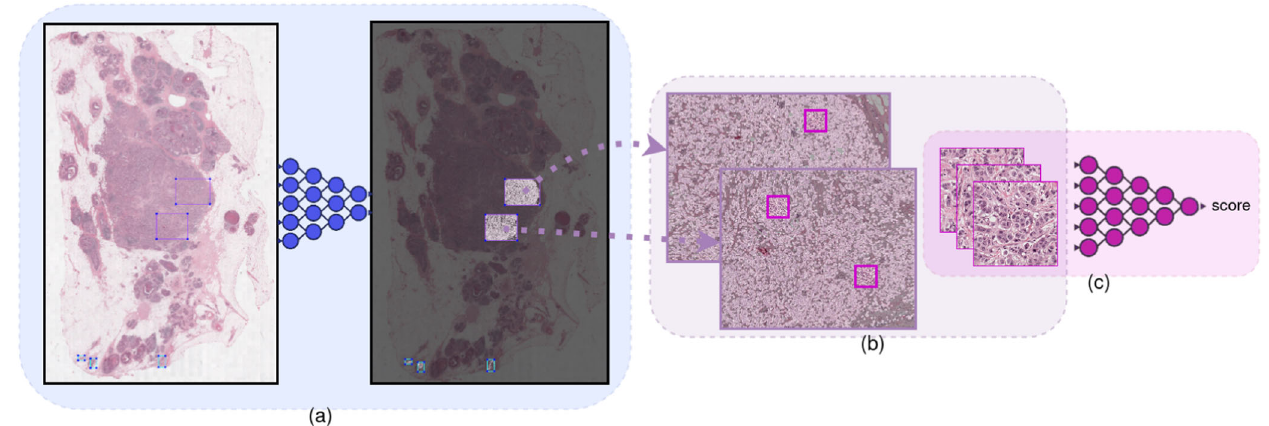
Fig. 11 Proposed methodology for learning nuclear pleomorphism scoring by tumor morphology as a spectrum. Patches were sampled from areas with high nuclear composition ( a , b ) using epithelial cell detection network. The weights of the epithelial cell detection network ( a ) were kept frozen during the training of the deep regression network ( c ) for learning pleomorphism